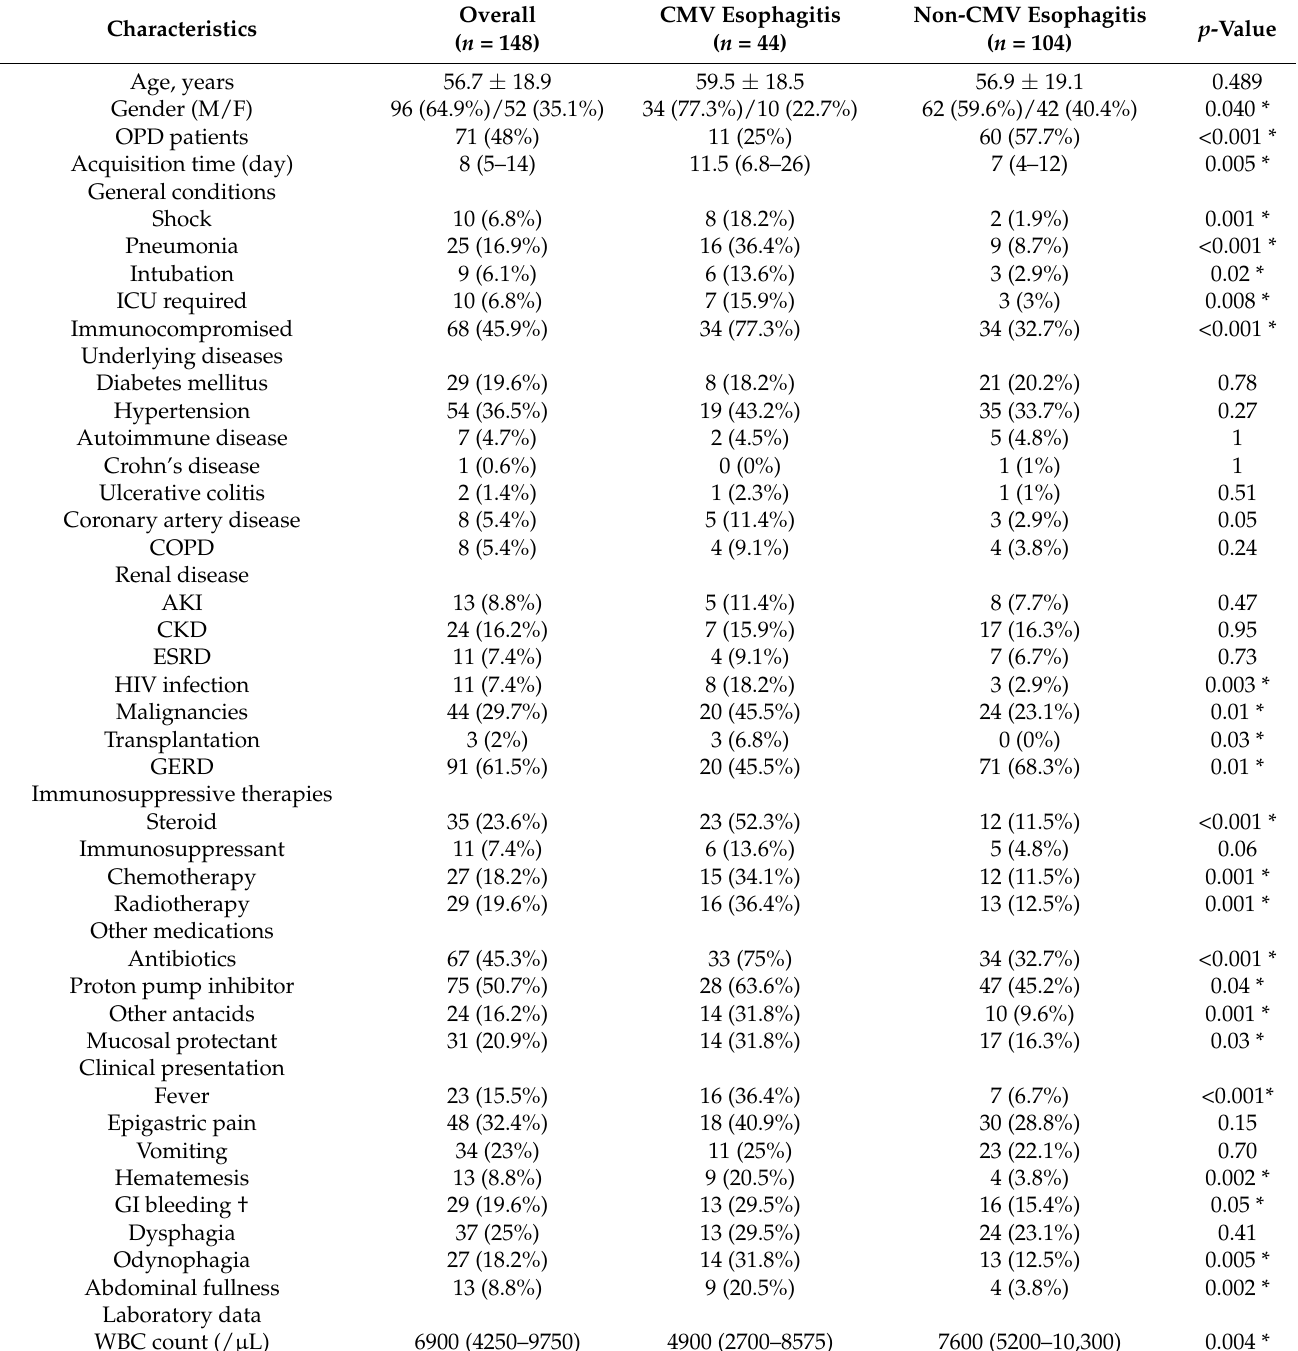
Table 1. Baseline characteristics of patients with and without CMV